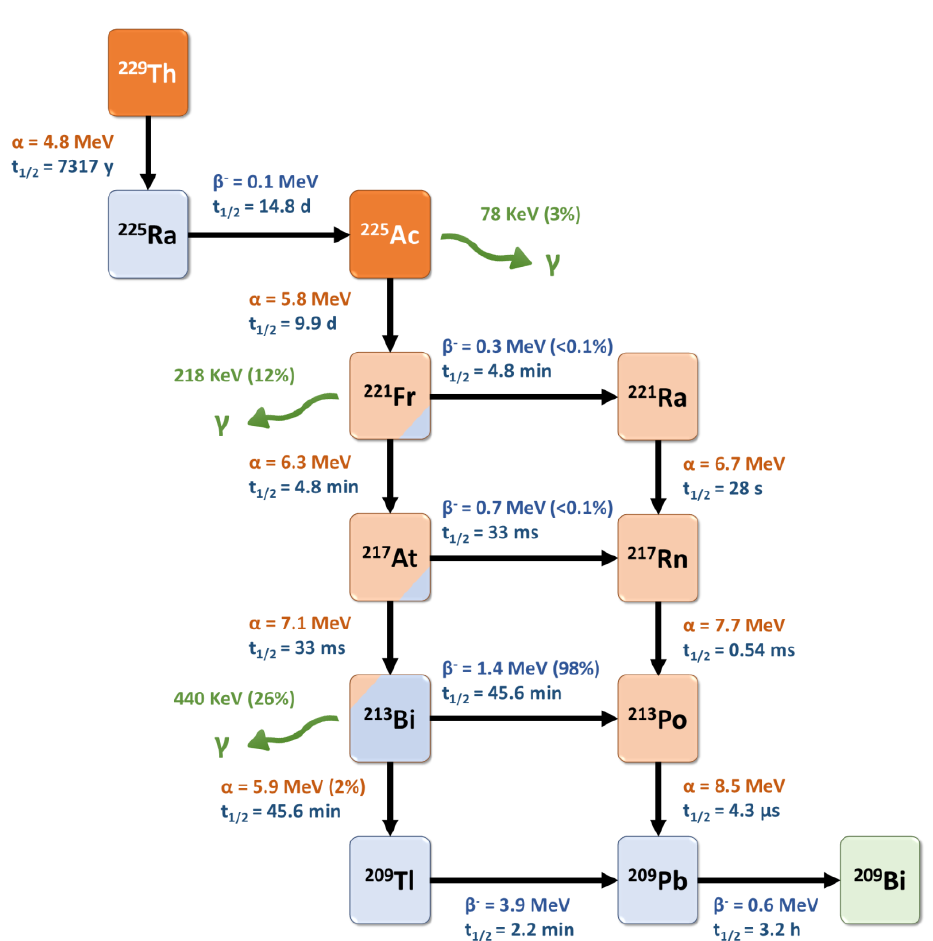
Figure 3. Decay scheme for one type of production and radioactive decay of 225 Ac.